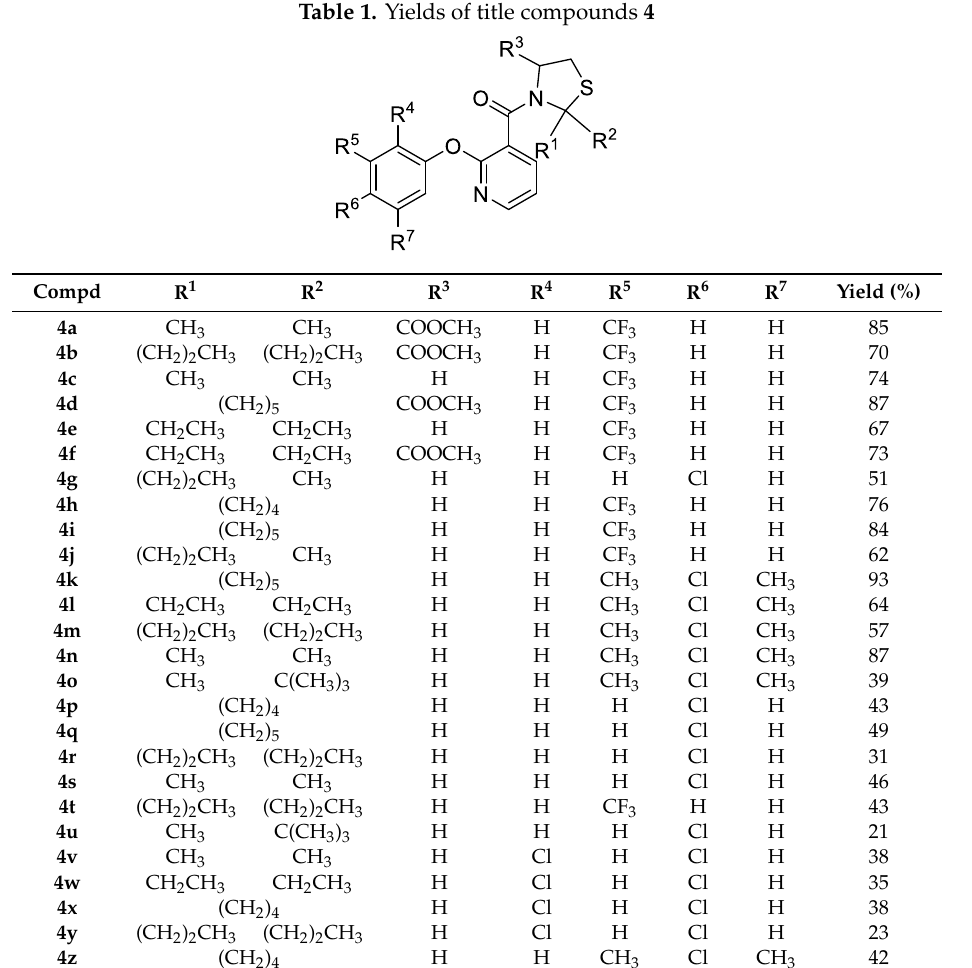
Table 1. Yields of title compounds